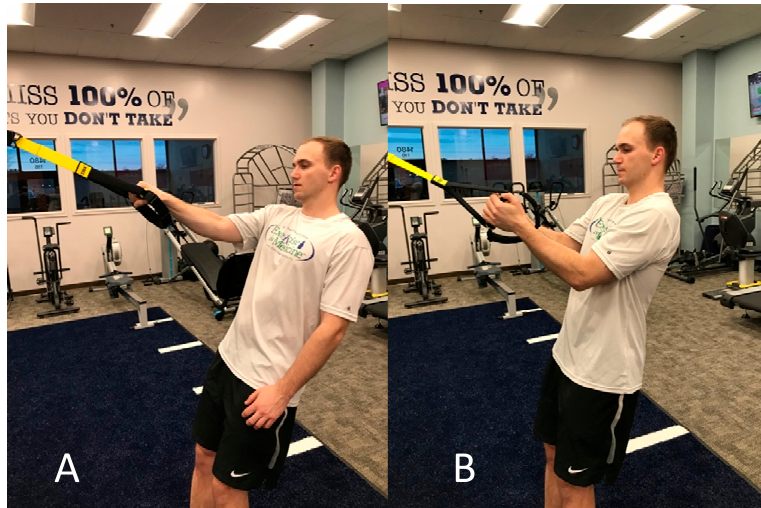
Figure 2. Eccentric elbow flexion with wrist in pronation using TRX ™.